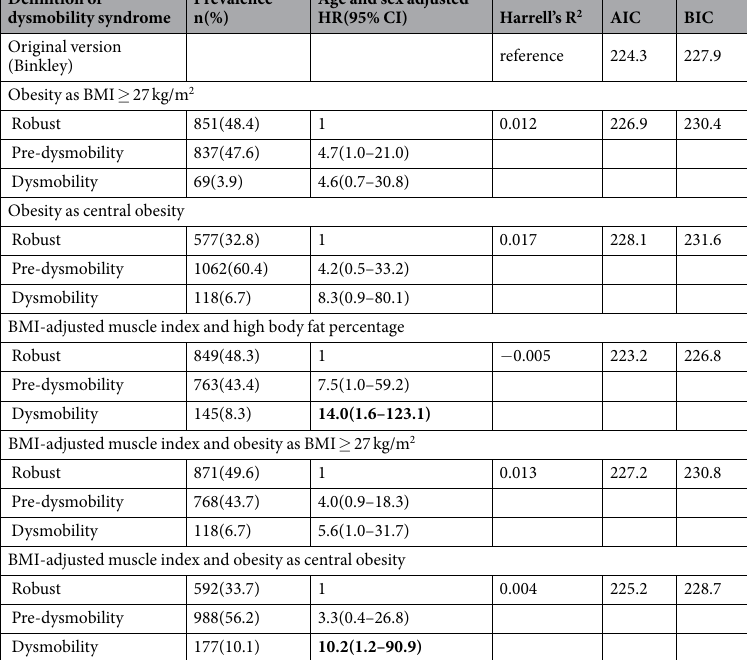
Table 3. Prevalence and risk of mortality by various definitions of dysmobility syndrome. HR, Hazard ratio; CI, confidence interval; AIC, Akaike Information Criterion; BIC, Bayesian information criterion; BMI, body mass index.